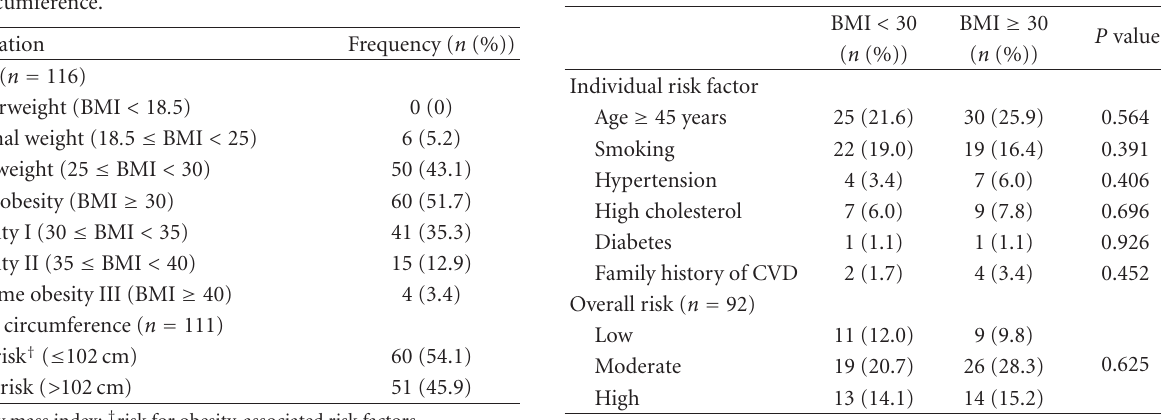
BMI: body mass index; CVD: cardiovascular disease; risk factors and categories defined by ACSM guidelines [42]: smoking: current